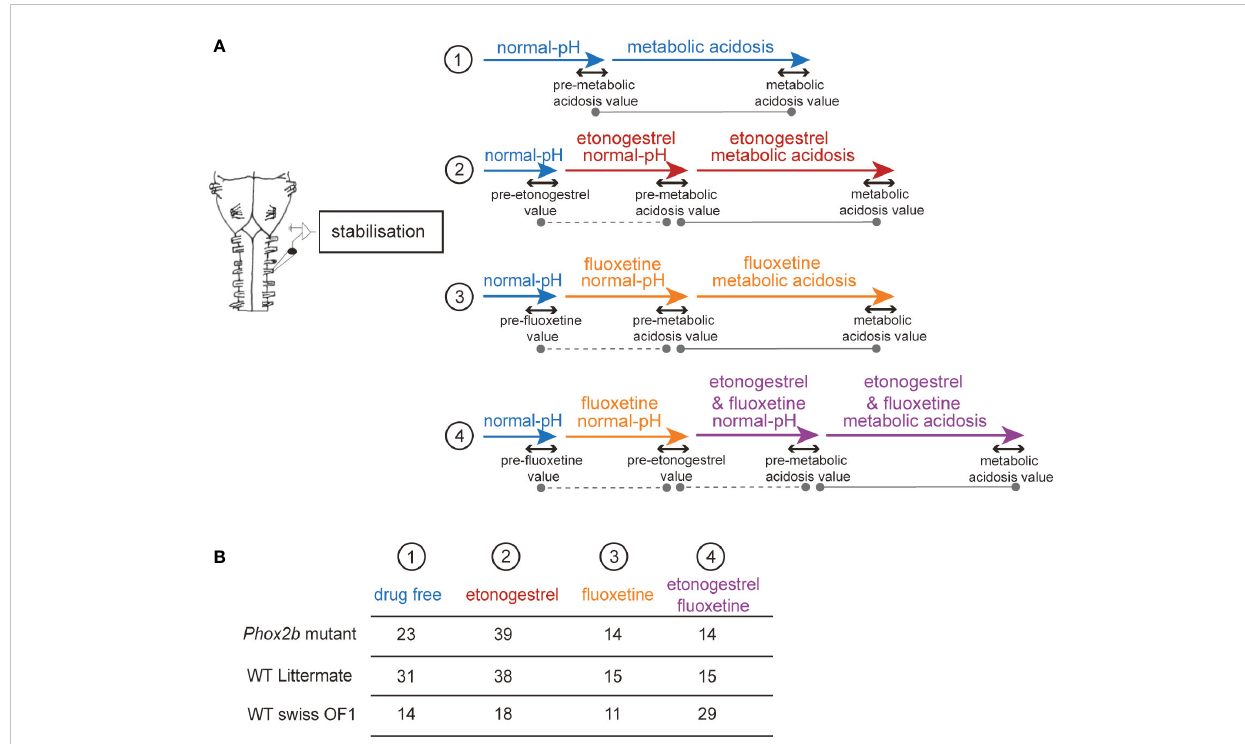
FIGURE 1 Schematic representation of the pharmacological protocols used. Flowchart of the protocols used in ex vivo medulla-spinal cord preparations from Phox2b mutants, wildtype littermates and wildtype Swiss OF1 mice (A) . Brie fl y, after a period allowing fR to stabilize, preparations were subjected to one of four protocols: 1) preparations were exposed to drug-free normal-pH and metabolic acidosis conditions, 2) preparations were exposed to drug-free normal-pH followed by exposure to etonogestrel under normal-pH and then metabolic acidosis conditions, 3) preparations were exposed to drug-free normal-pH followed by exposure to fl uoxetine under normal-pH and then metabolic acidosis conditions, 4) preparations were exposed to drug-free normal-pH, then to fl uoxetine under normal-pH followed by etonogestrel associated with fl uoxetine under normal-pH and then metabolic acidosis conditions. Table indicating the number of ex vivo preparations used for each protocol in Phox2b mutants, wildtype littermates and wildtype Swiss OF1 mice (B) . The dotted grey lines represent the comparison made to determine the in fl uence of a drug in normal-pH. The grey lines represent the comparison made to determine the response to metabolic acidosis under drug-free or drug exposure